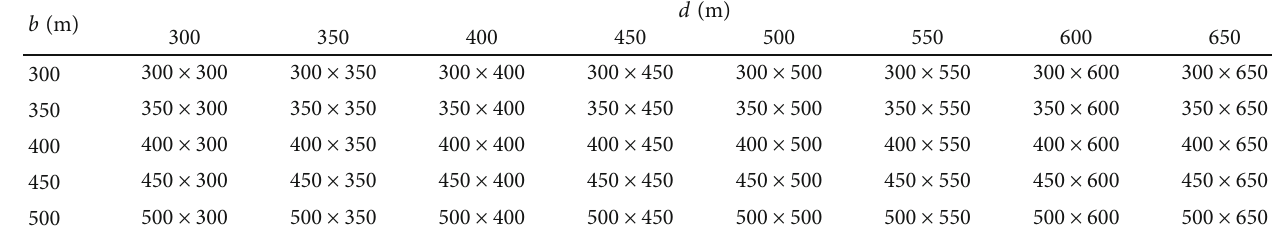
Table 4: Orthogonal experiment design of well spacing (inverted 9-spot well pattern).